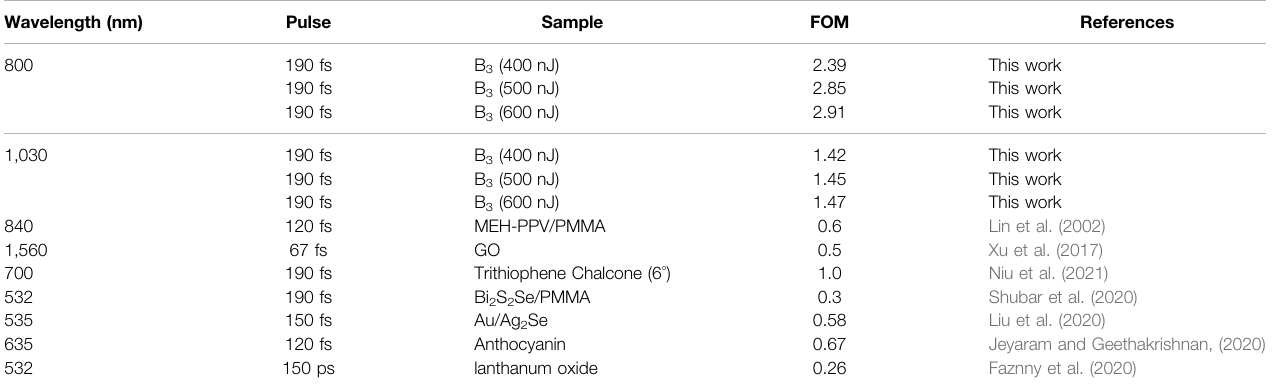
TABLE 3 | The nonlinear fi gure of merit (FOM) of different materials. Wavelength